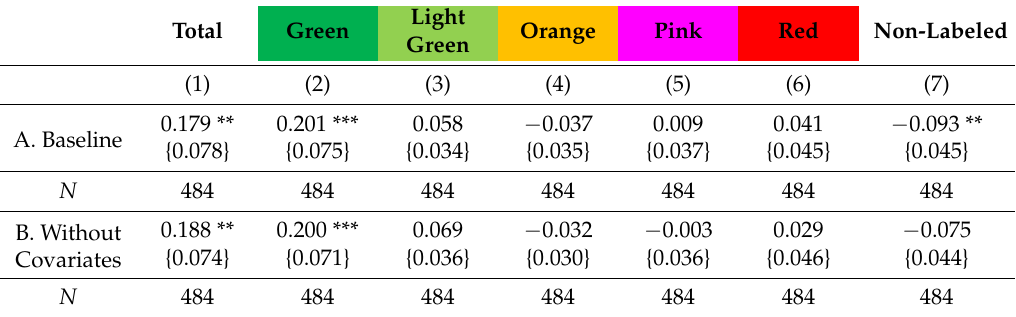
Table A1. Robustness checks for the unconditional effect of providing Nutri-Score Label information on total expenditure and expenditure by color.